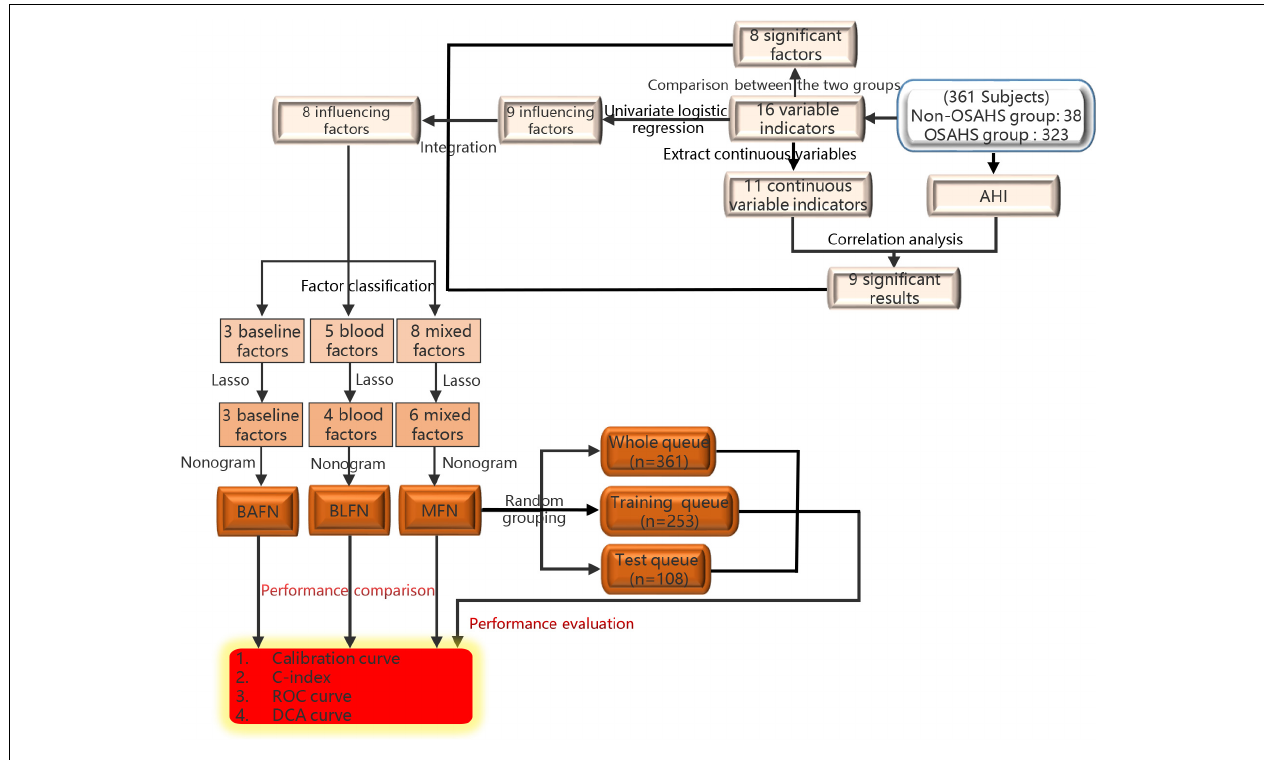
FIGURE 1 | The flow chart of the entire study.